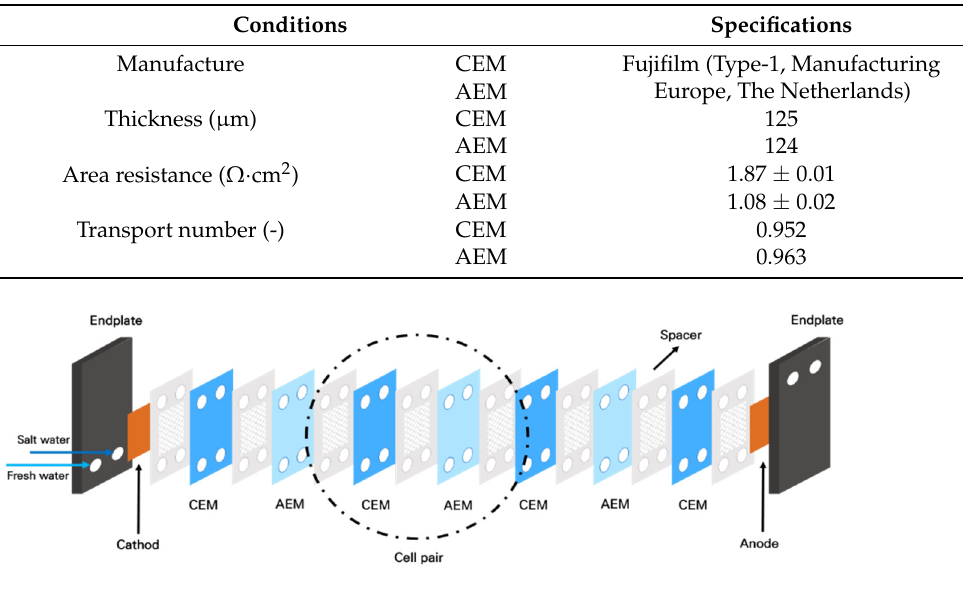
Figure 2. Schematic diagram of the RED stack.